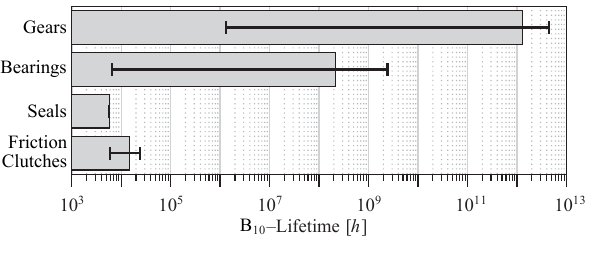
Figure 12: B 10 -lifetimes